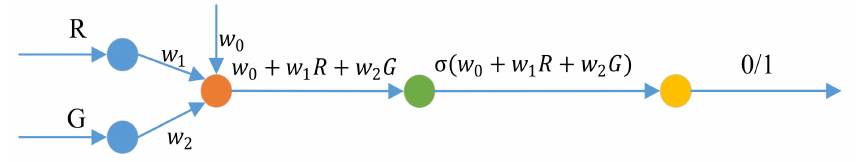
Figure 3. Diagram of binary logistic